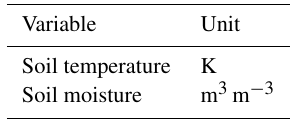
Table 7. WRF sub-surface parameters (with units) at 4 levels (5, 25, 75 and 150cm below the surface) archived by ICHEC at 1h intervals.